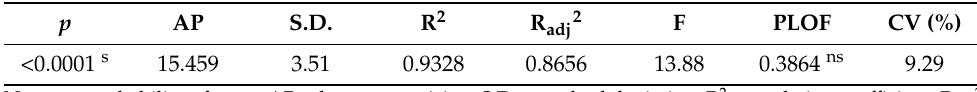
Table 3. ANOVA results of response variable.